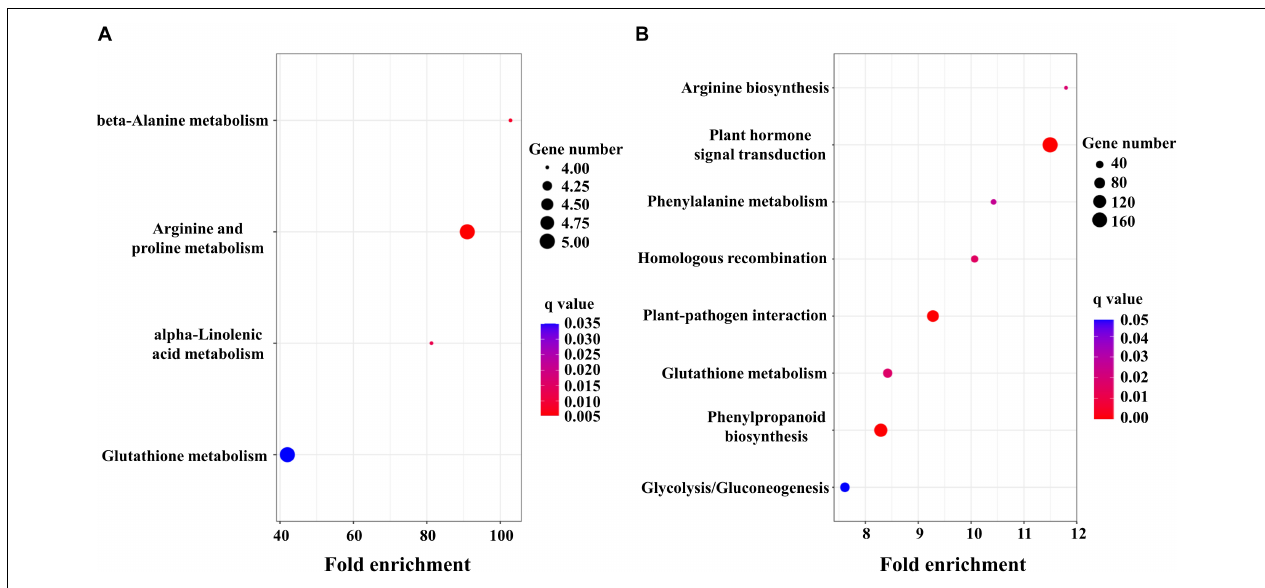
FIGURE 3 | KEGG enrichment analysis of DEGs in Ae. tauschii (A) and T. aestivum (B) . Fold enrichment in a pathway means the ratio of the number of observed DEGs and expected DEGs.